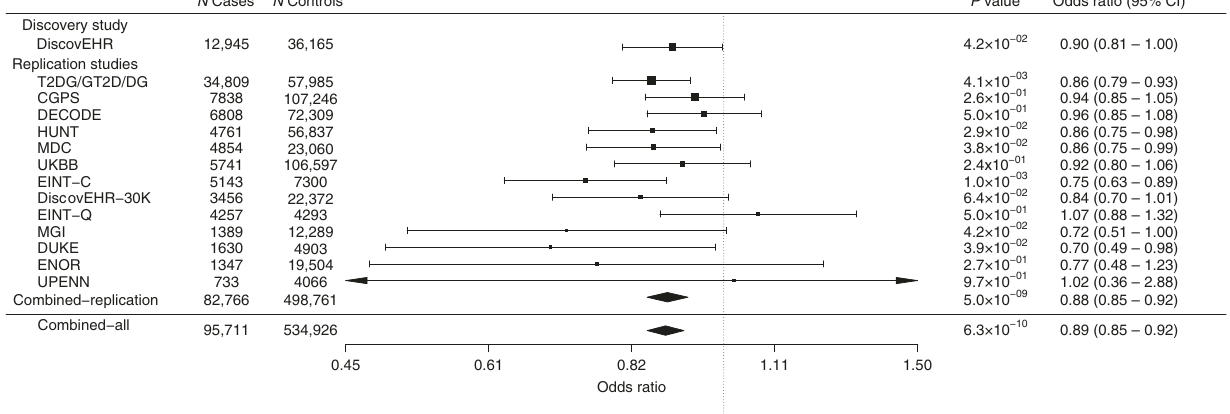
Table 1 Associations of ANGPTL4 loss-of- function variants and type 2 diabetes